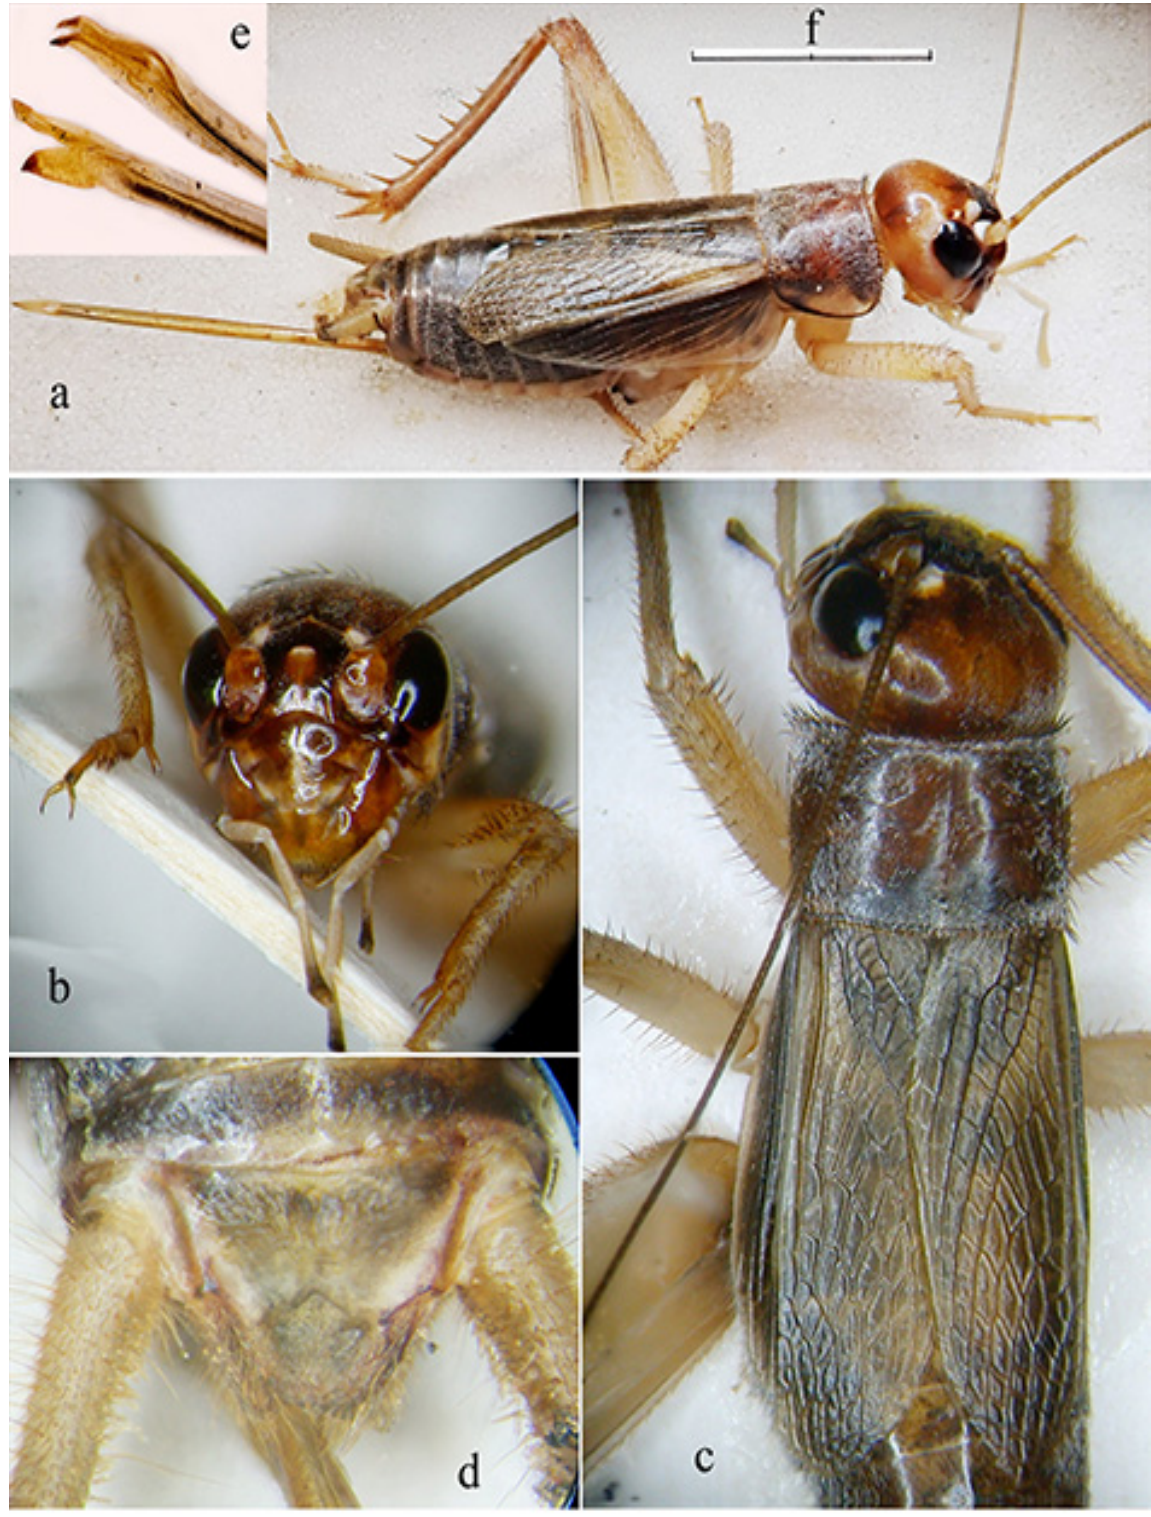
Figure 7. Adult female characters of Acheta pantescus n. sp. ( a ) lateral view; ( b ) head in frontal view; ( c ) dorsal view of head, pronotum and tegmina; ( d ) last tergite; ( e ) apex of ovipositor valves; ( f ) scale (a: 7.3 mm; b: 4.2 mm; c: 3.8 mm; d: 3.5 mm; e: 1.0 mm).